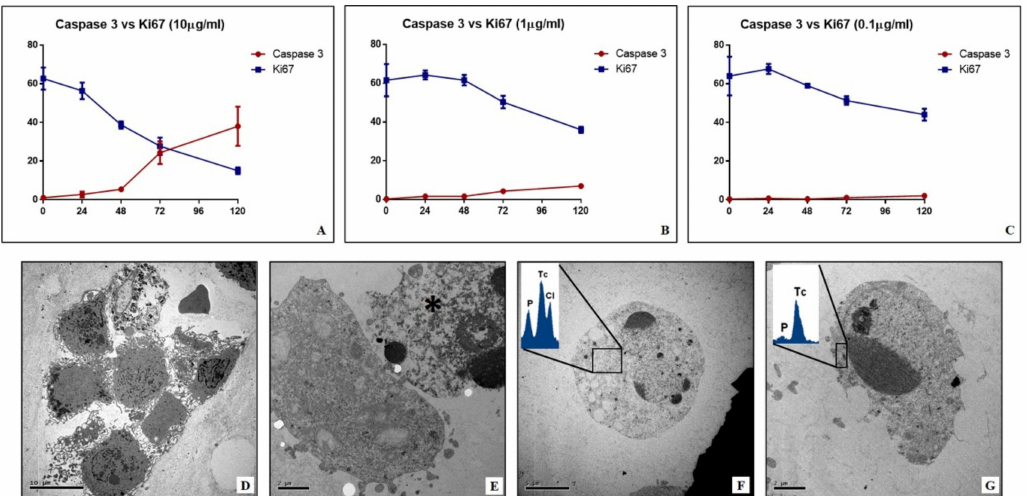
Figure 3. Comparison between apoptosis and proliferation of BT474 breast cancer cells treated with [99mTc]Tc-Sestamibi and ultrastructural analysis. ( A ) Graph shows the number of both caspase-3- and Ki67-positive BT474 breast cancer cells after 24, 48, 72, 96, and 120 h of [99mTc]Tc-Sestamibi incubation (10 µ g/mL). ( B ) Graph displays the number of both caspase-3- and Ki67-positive BT474 breast cancer cells after 24, 48, 72, 96, and 120 h of [99mTc]Tc-Sestamibi incubation (10 µ g/mL). ( C ) Graph shows the number of both caspase-3- and Ki67-positive BT474 breast cancer cells after 24, 48, 72, 96, and 120 h of [99mTc]Tc-Sestamibi incubation (10 µ g/mL). ( D ) Electron micrograph displays ultrastructure of BT474 breast cancer cells (CTRL T0). ( E ) Image shows an apoptotic breast cancer cell (asterisk) close to a non-apoptotic cell (10 µ g/mL at 48 h). ( F , G ) EDX spectrum revealed the presence of [99mTc]Technetium into the cytoplasm of apoptotic cells (10 µ g/mL at 120